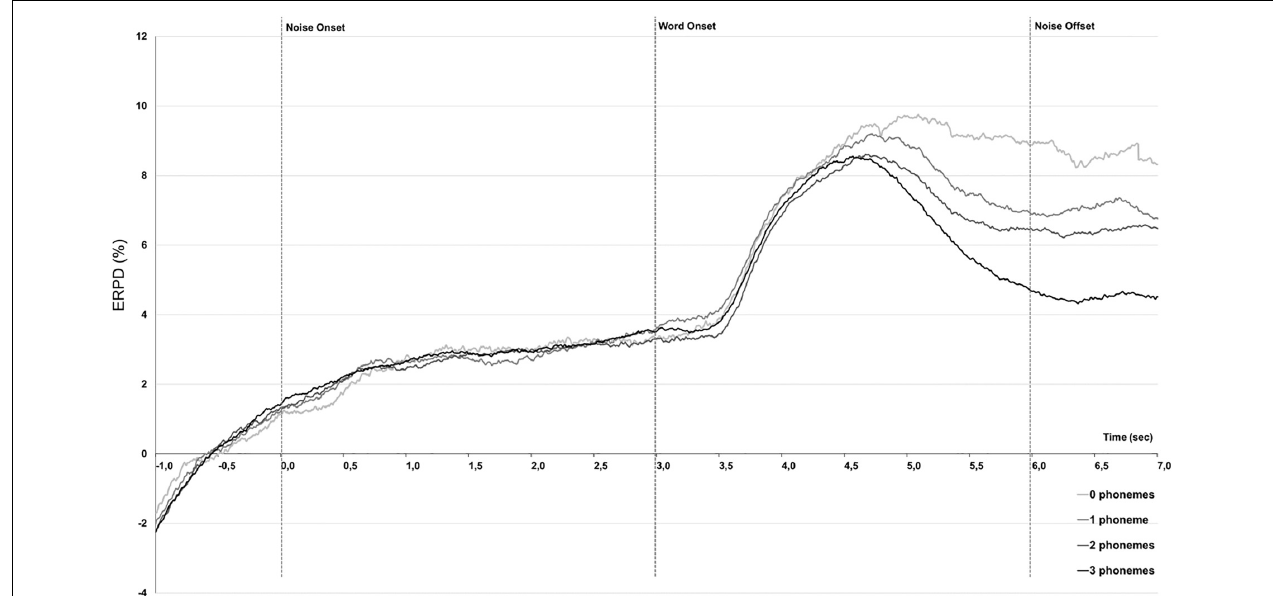
FIGURE 6 | Grand-averaged ( N = 10) pupillometry traces showing percent change in event-related pupil dilation (ERPD) analyzed across trials leading to 0, 1, 2, or 3 phonemes recognition.